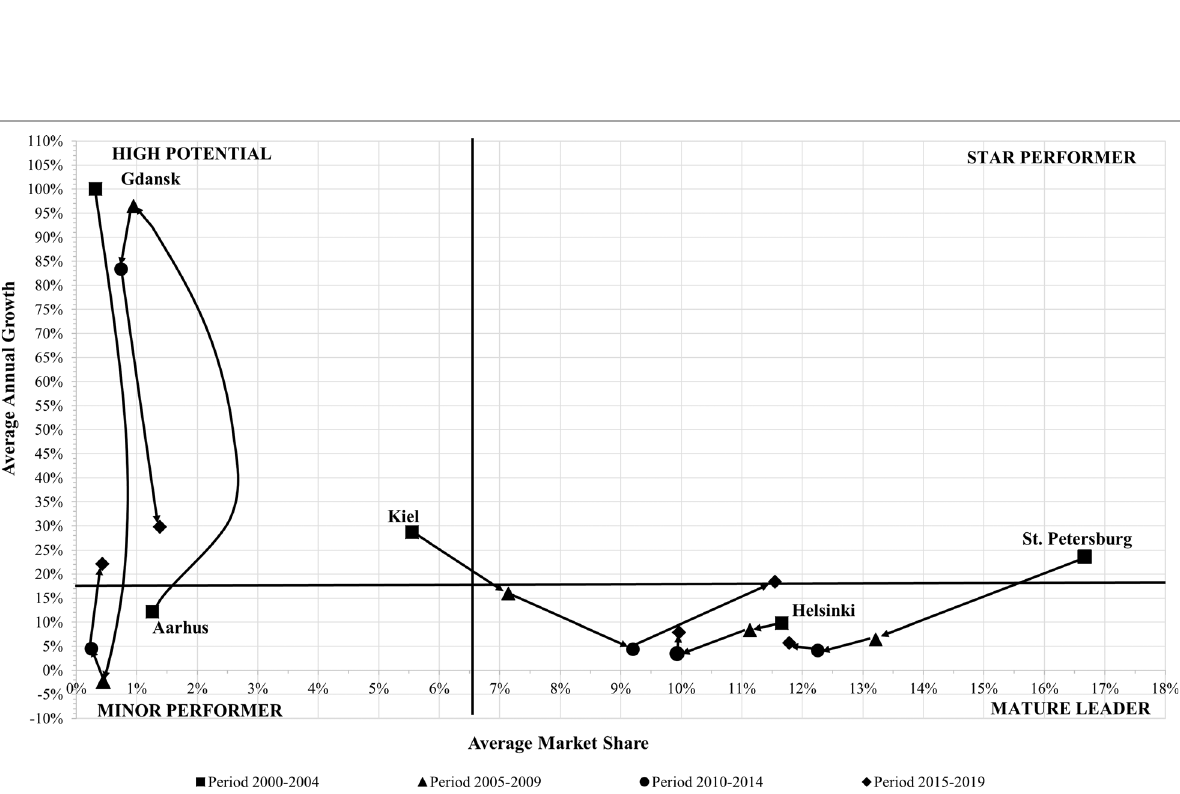
Fig. 6 Dynamic portfolio analysis of ports of Aarhus, Gdansk, Helsinki, Kiel and St. Petersburg during the 2000–2019 period. Source : Author’s